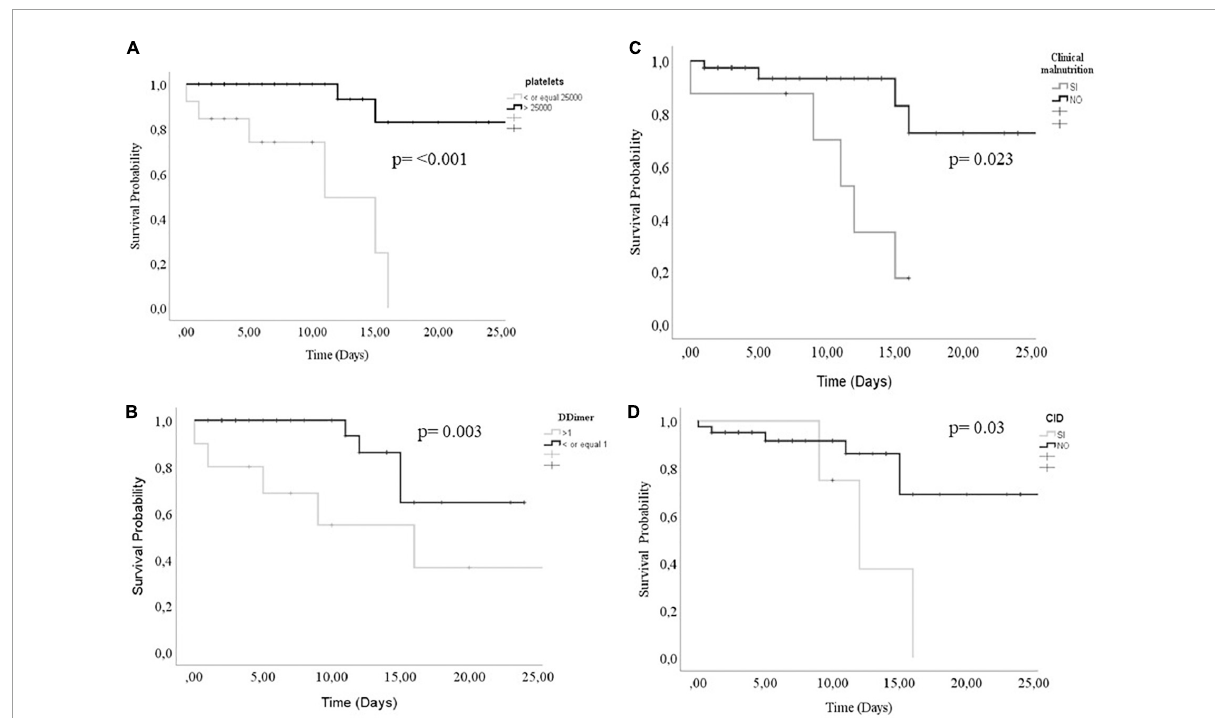
FIGURE1 Survival curves comparison according to panel (A) platelet count, (B) D-dimer concentration, (C) Clinical malnutrition, and (D) CID status. A log-Rank value of < 0.05 was considered statistically